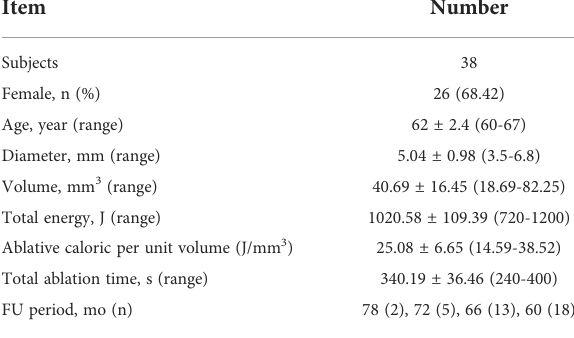
TABLE 1 Baseline characteristics of patients with PTMC treated with PLA.